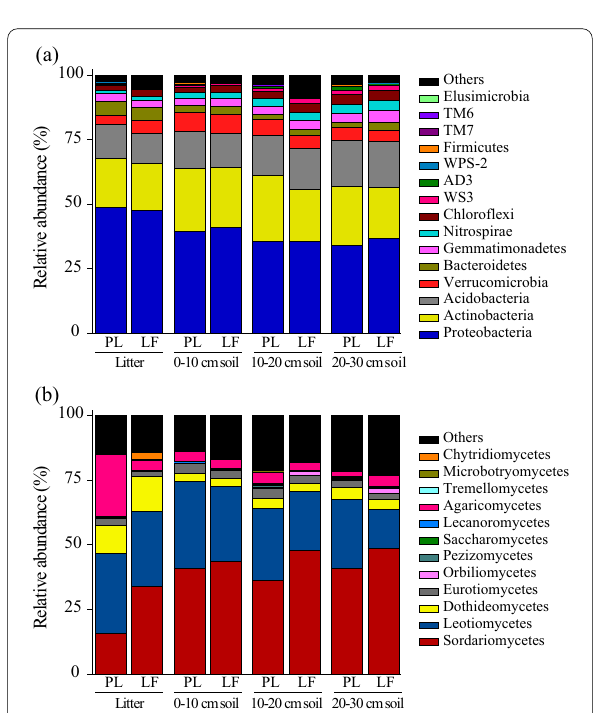
Fig. 3 Relative abundance of ( a ) bacterial phyla and ( b ) fungal classes of forest litter and soil of the monoculture Larix gmelinii plantation (PL) and mixed L. gmelinii – Fraxinus mandshurica plantation (LF). Values are presented as means